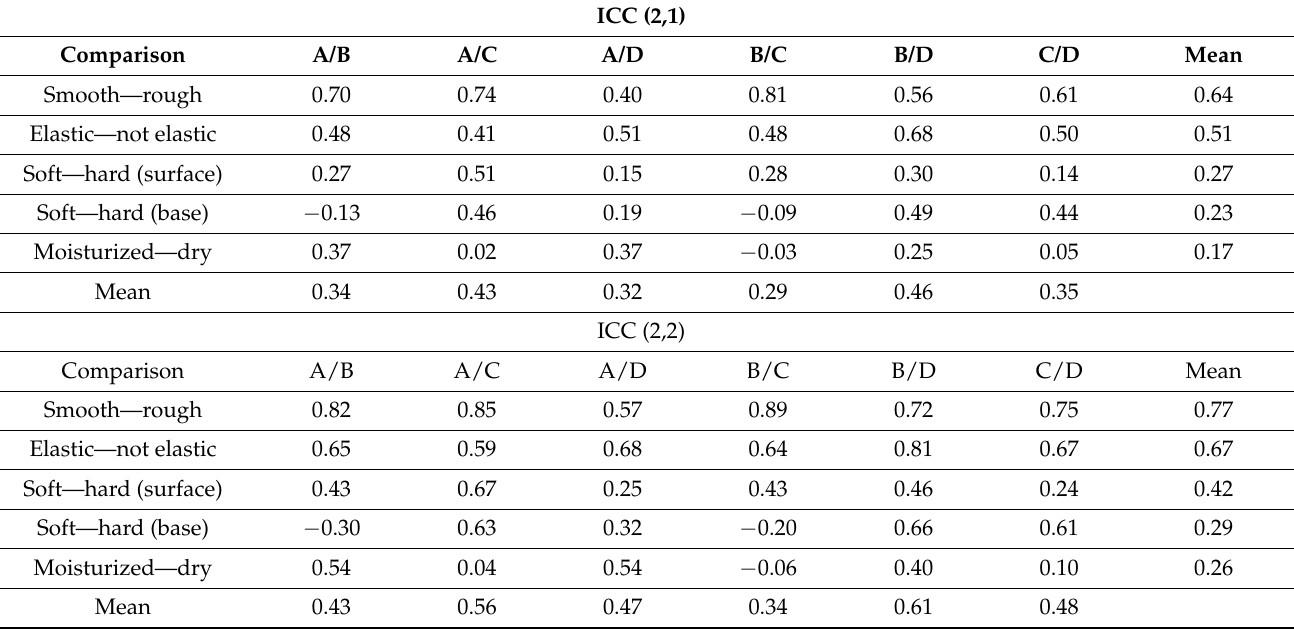
Table 9. Intraclass correlation coefficient (ICC) (2,1) and ICC (2,2)